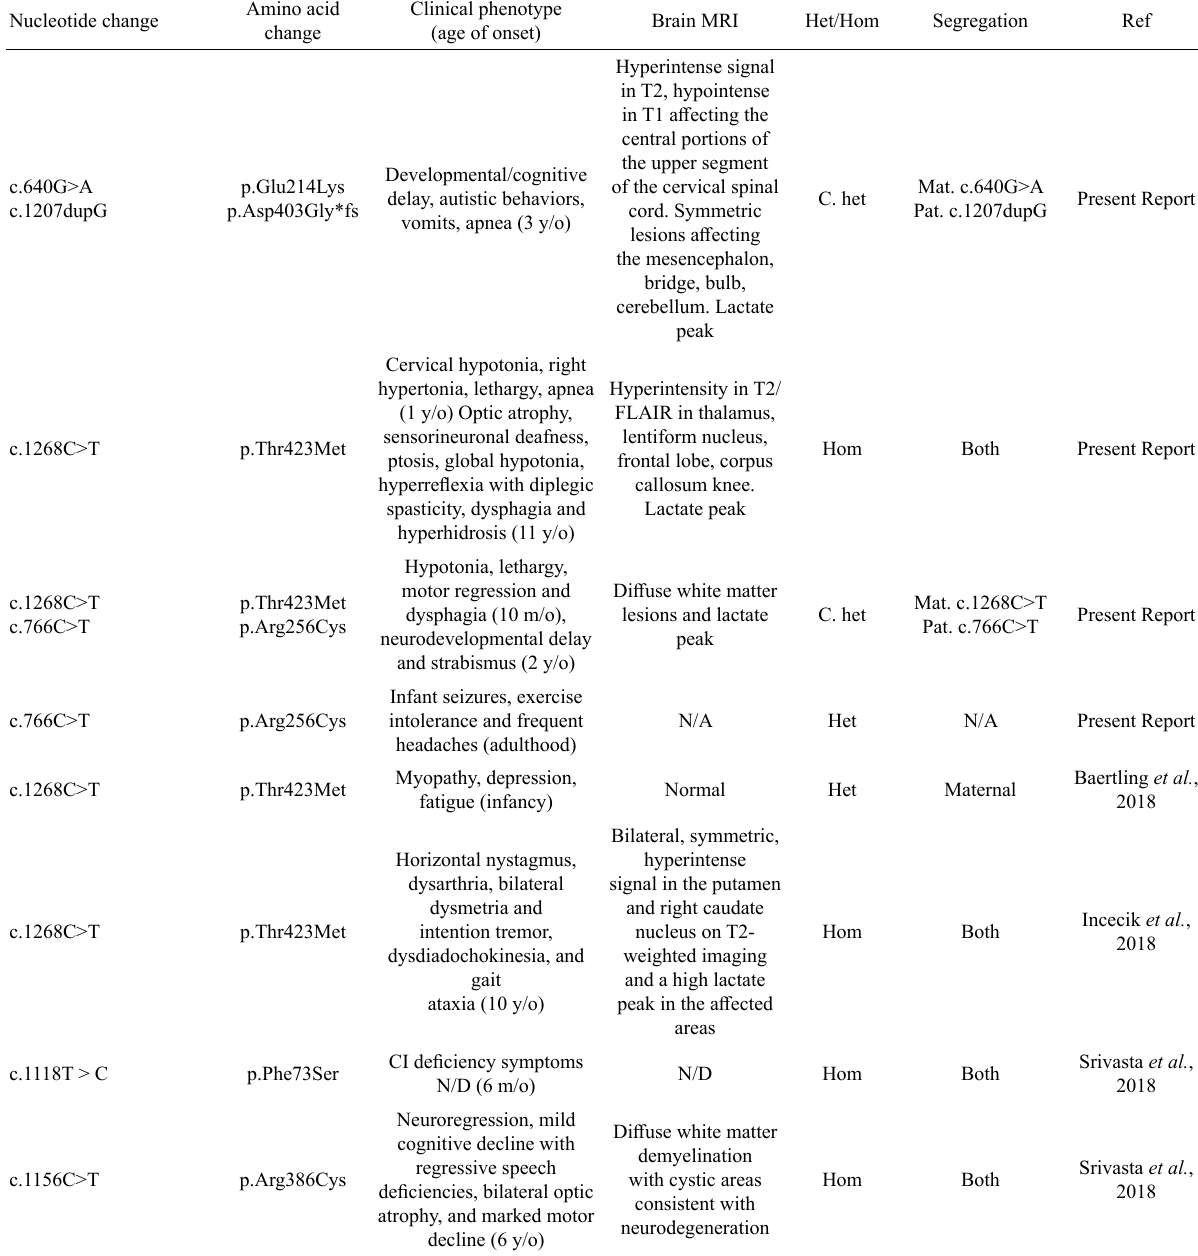
Table 1 ‒ Clinical and molecular features of patients presenting NDUFV1 mutations. Nucleotide and amino acid change, clinical phenotype, brain MRI, Het/Hom (Heterozygous or homozygous), segregation and references are described. C.het. (Compound Heterozygous); Hom (Homozygous); Mat. (maternal); Pat. (Paternal); Ref (Reference). Lines in blue: Cases of p.Thr423Met, lines in green: cases of p.Glu214Cys. Amino acid Nucleotide change